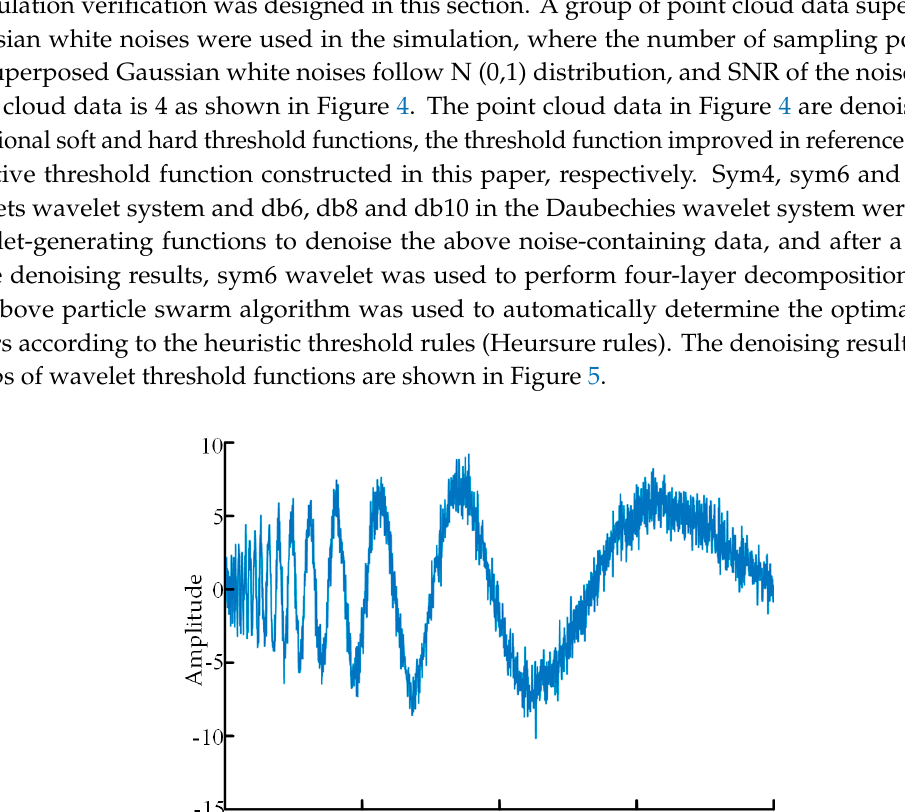
Table 2. The comparison of results for di ff erent threshold